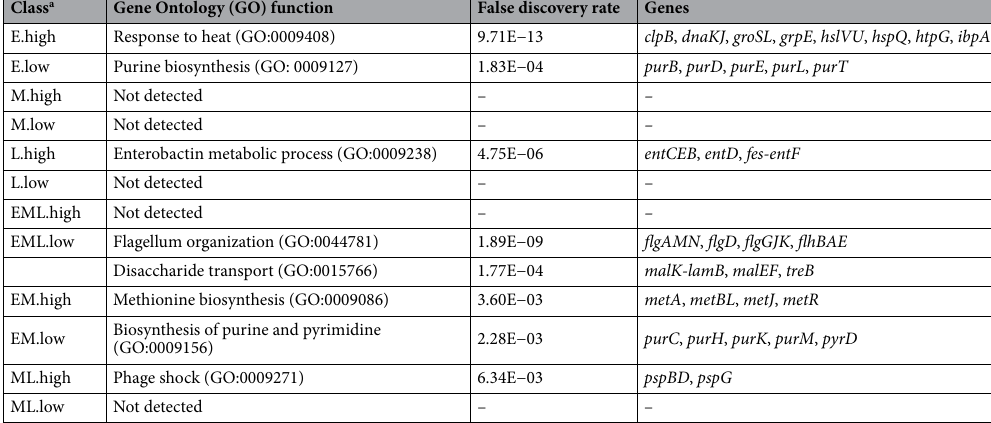
Table 1. Functional enrichment of DEGs characteristic of early, middle, and late responses. a Time stages are early (E; 2 and 10 min), middle (M; 0.5, 1, and 2 h), and late (L; 4, 8, and 40 h), and the gene expression is high or low. See Fig. 2C for the gene expression